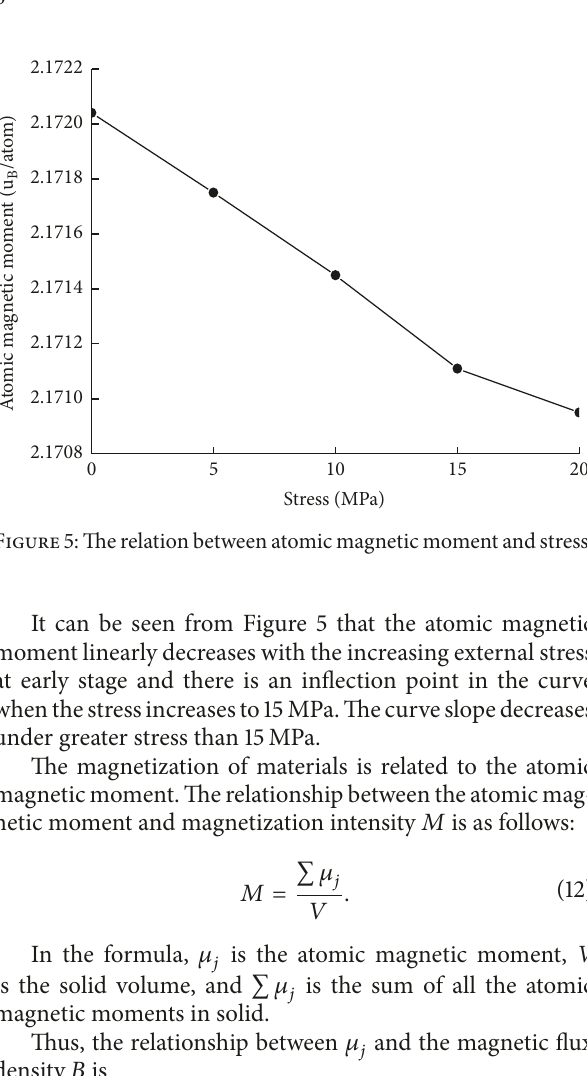
It can be seen from Figure 5 that the atomic magnetic moment linearly decreases with the increasing external stress at early stage and there is an inflection point in the curve when the stress increases to 15 MPa. The curve slope decreases under greater stress than 15